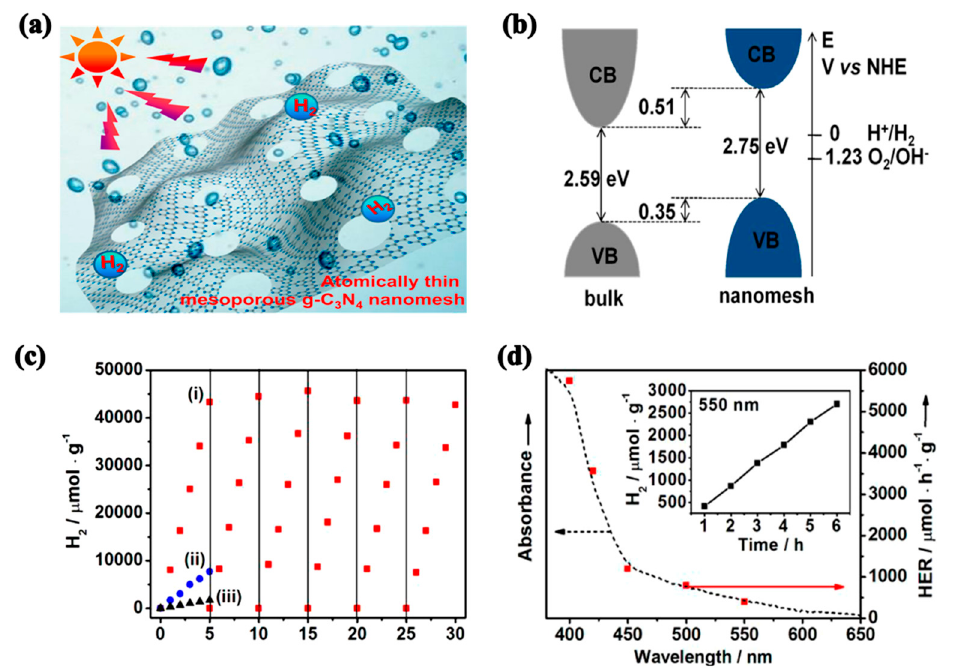
Figure 4. ( a ) Schematic illustration of atomically thin mesoporous g-C 3 N 4 nanomesh photocatalyst and ( b ) a band gap schematic of the monolayer mesoporous g-C 3 N 4 nanomesh and bulk counterparts. ( c ) Hydrogen production rate of the monolayer mesoporous g-C 3 N 4 nanomesh, the bulk counterpart,